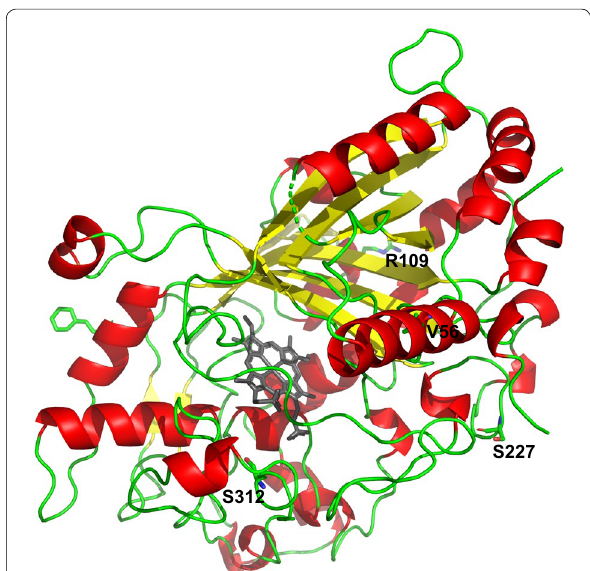
Fig. 3 Protein model of 4D4 variant, created with PyMOL using crystal structure of DyP4 F194Y variant (PDB 6FSK) as template. Missense mutations in 4D4 are indicated (I56V, K109R, N227S and N312S)